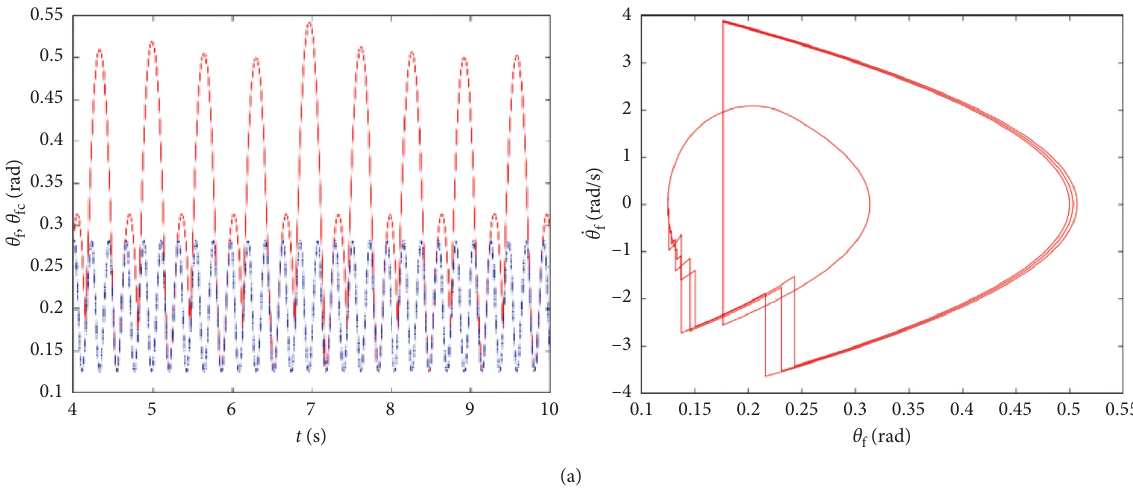
, blue represents θ ). (c) Chaos ( σ � 0 . 004 m; f fc